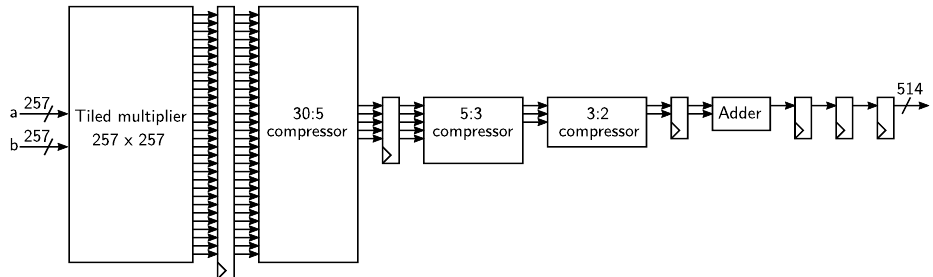
Figure 6: The 257-bit signed multiplier with